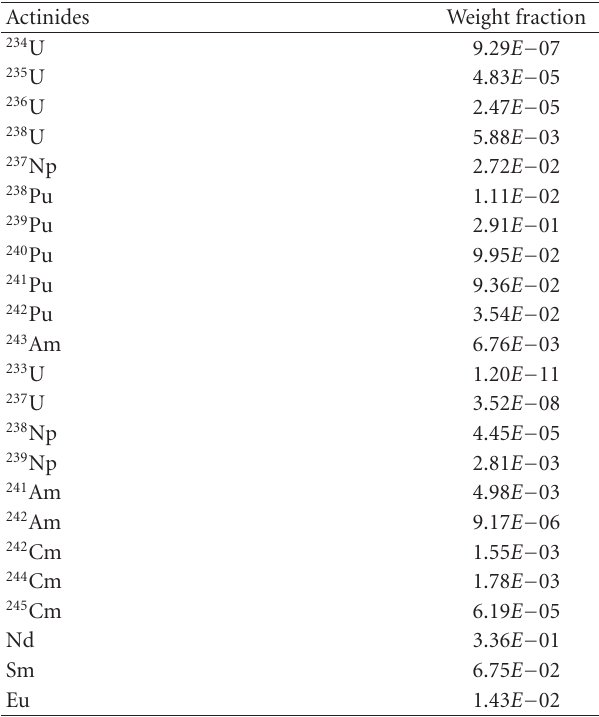
Table 2: Fuel composition (normalized) after reprocessing.